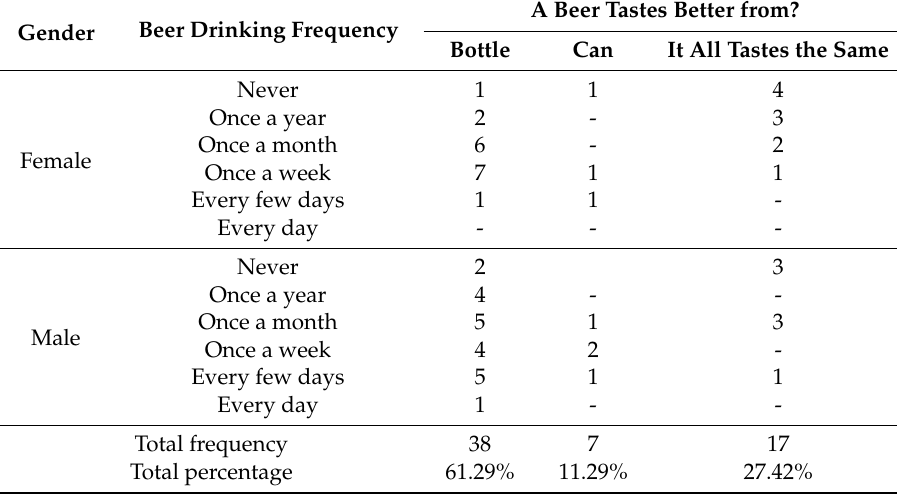
Table 1. Results of the